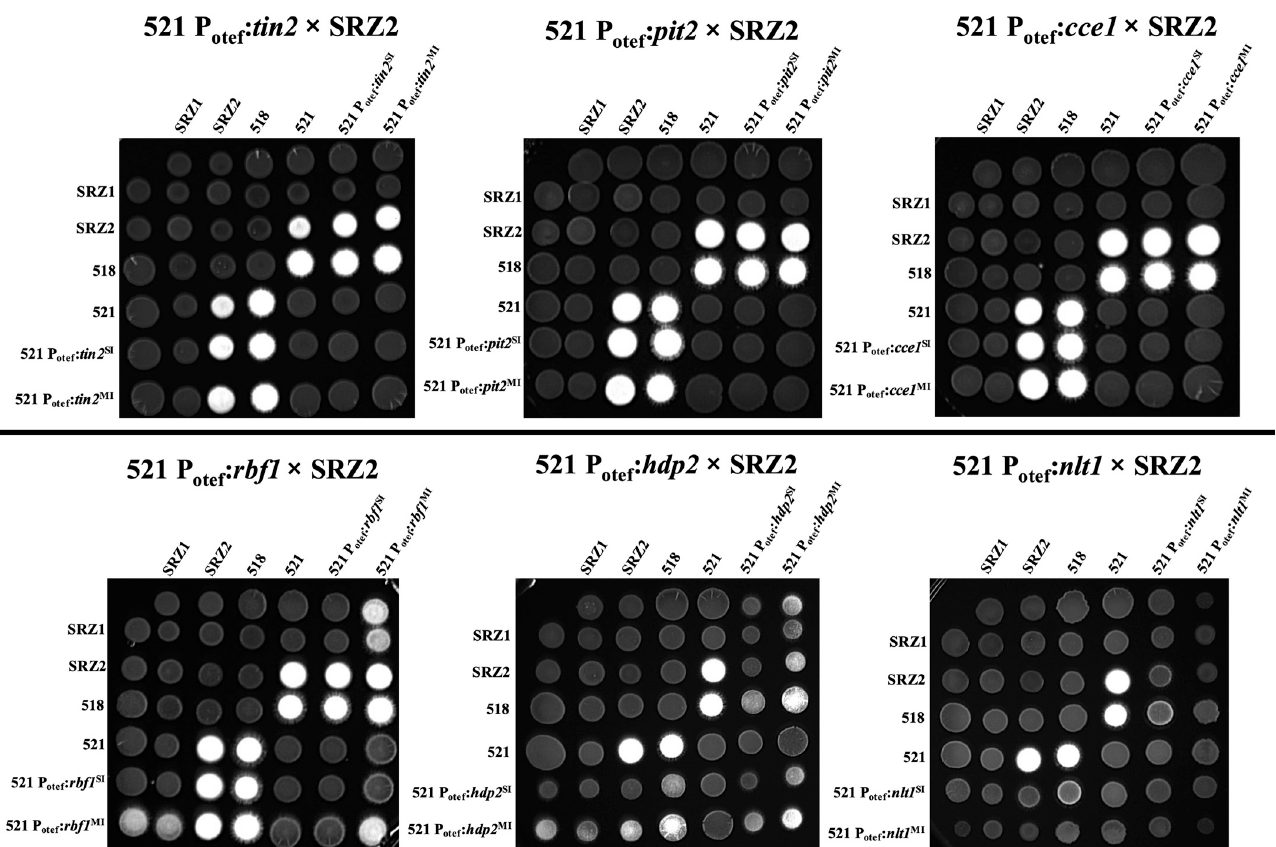
Figure 5. Constitutively expressed transcription factors altered filament formation, while effector expression did not. The indicated mixtures of compatible haploid strains were spotted onto PDA + charcoal plates and incubated for three days in the dark. White fuzz indicates the formation of filaments.